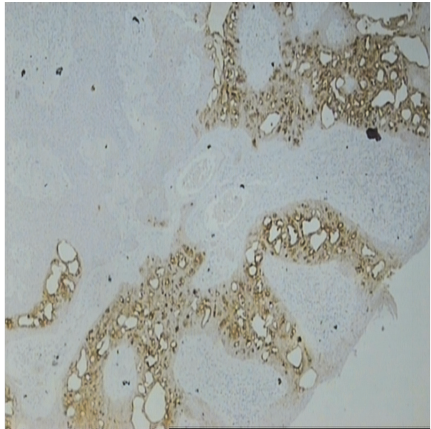
Figure 1: Macroscopic view of the smooth, reddish, and purulent tumor. No signs of infiltration are seen in the surrounding skin.